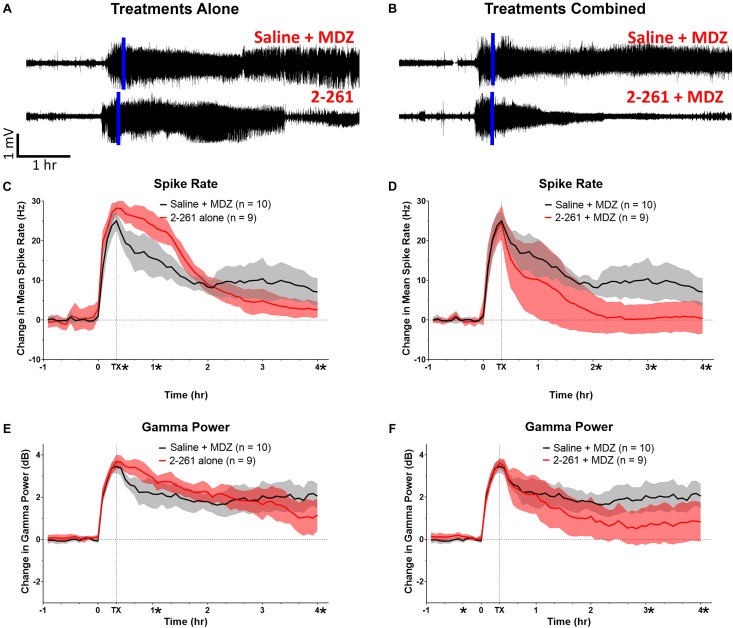
Effect of treatment by 2-261 alone or combined with MDZ after soman intoxication. Representative example of EEG recordings from subject rats after soman challenge and treated 20 min after the onset of SE (indicated by vertical blue line) with either saline plus 1.8 mg/kg MDZ i.m. or 120 mg/kg 2-261 i.p. alone (A). EEG traces in (B) show rats treated with saline combined with MDZ or 2-261 combined with MDZ. Summary of the change in gamma power and mean spike frequency after 2-261 treatment alone (C,E) or combined with MDZ (D,F) after soman exposure. Asterisks indicate time points at which there was a significantly different response between treatment groups in spike rate or gamma power as measured by t-test, N = 9–10 rats for each treatment group. MDZ, midazolam; hr, hour; mV, millivolts; Hz, hertz; dB, decibels.